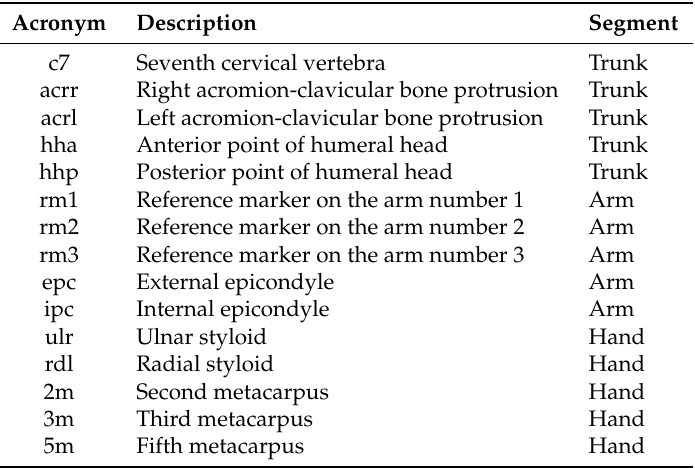
Figure 2. ( a ) Initial and ( b ) final configuration of markers. ( a ) Three reference markers were included in the forearm to act as reference for the markers of the hand and the elbow as any marker needs a reference system with three markers; ( b ) The forearm reference markers were removed by referencing the markers of the elbow to the reference markers of the arm and the ones of the hand to the reference system of the hand itself. Table 4. Biomechanical